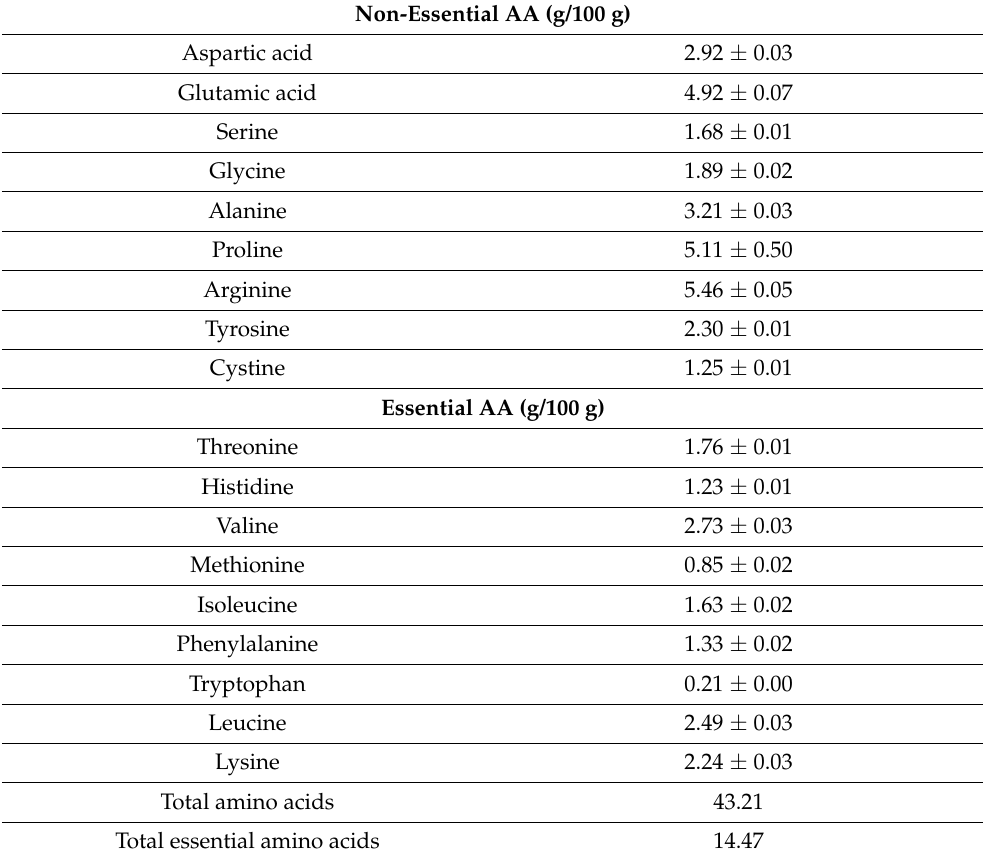
Table 3. Amino acid (AA) composition of odonate Pantala